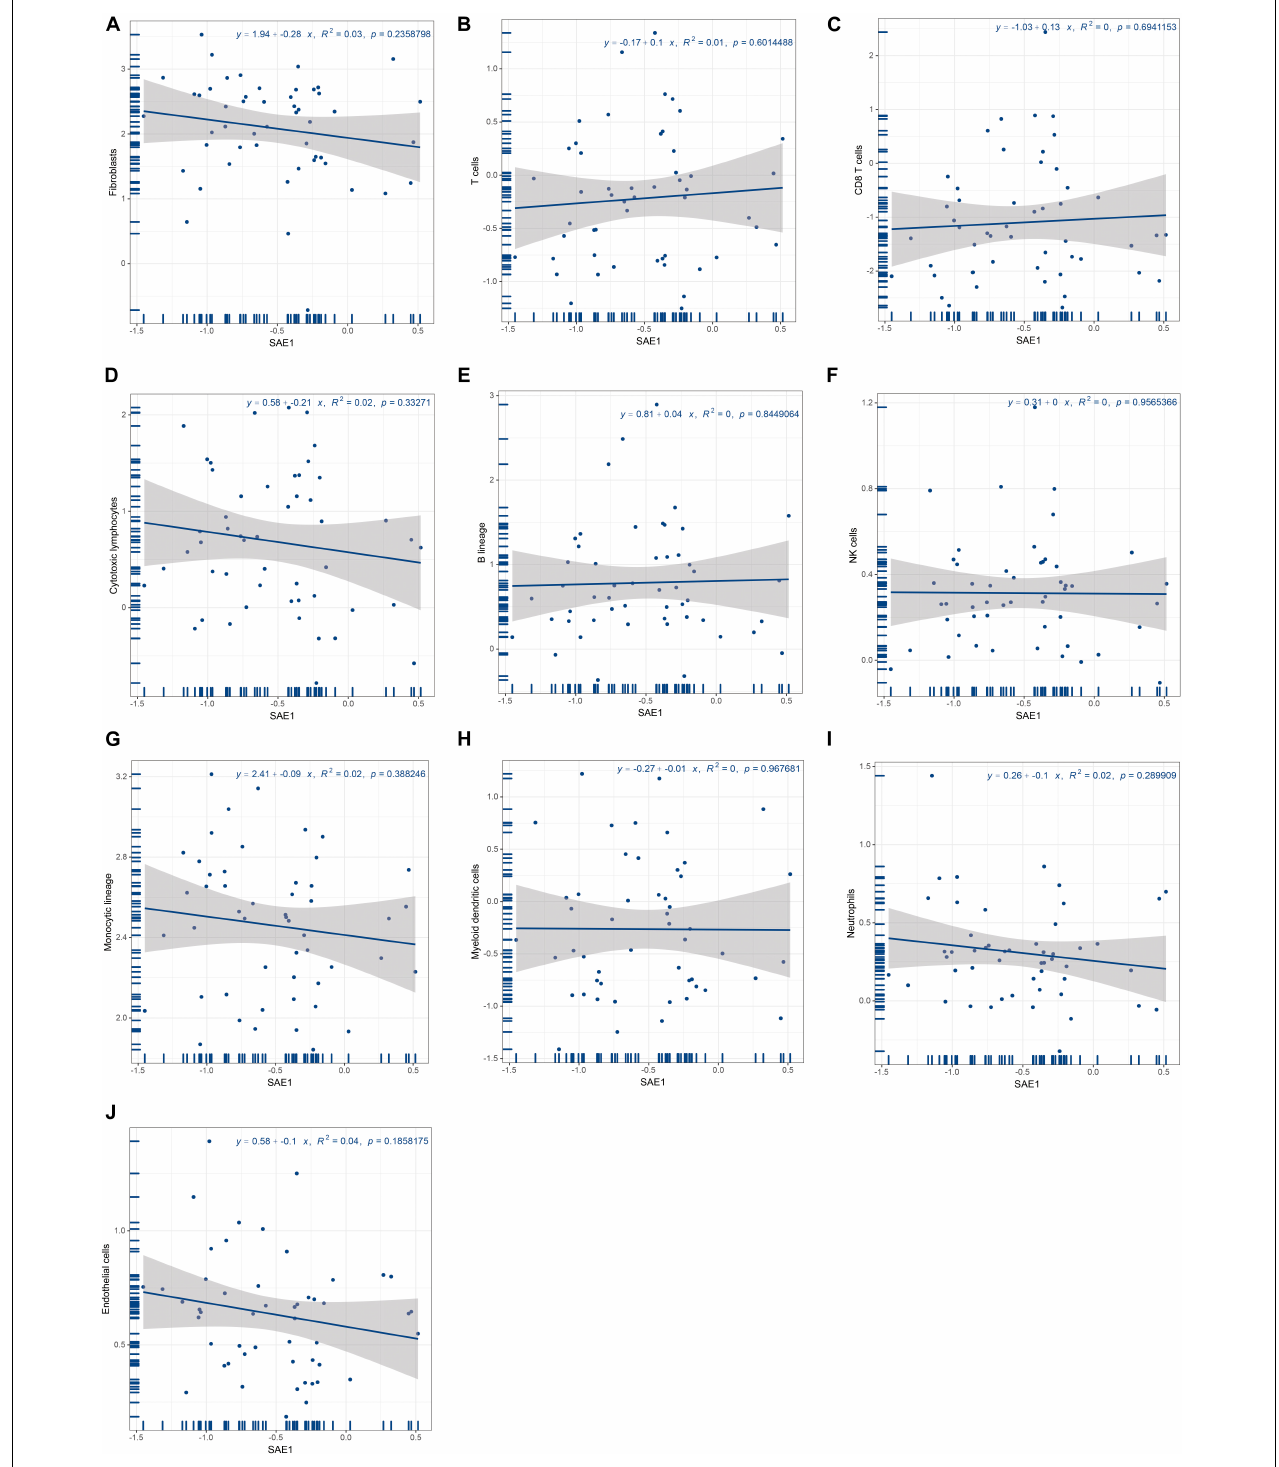
FIGURE 4 | Relationships of SAE1 with tumor-infiltrating immune cells. (A) Correlation between SAE1 expression and fibroblasts. (B) Correlation between SAE1 expression and T cells. (C) Correlation between SAE1 expression and CD8 T cells. (D) Correlation between SAE1 expression and cytotoxic lymphocytes. (E) Correlation between SAE1 expression and B lineage. (F) Correlation between SAE1 expression and NK cells. (G) Correlation between SAE1 expression and monocytic lineage. (H) Correlation between SAE1 expression and myeloid dendritic cells. (I) Correlation between SAE1 expression and neutrophils. (J) Correlation between SAE1 expression and endothelial